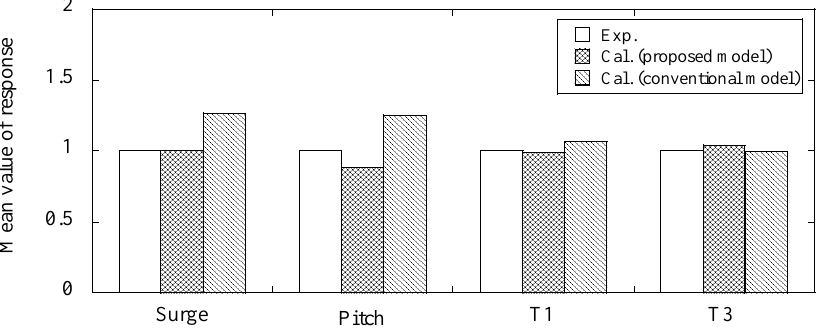
Figure 11. Comparison of predicted and measured mean values of the displacement, rotation and mooring tension in the combined wave-current condition (regular wave with T = 2.5 s).